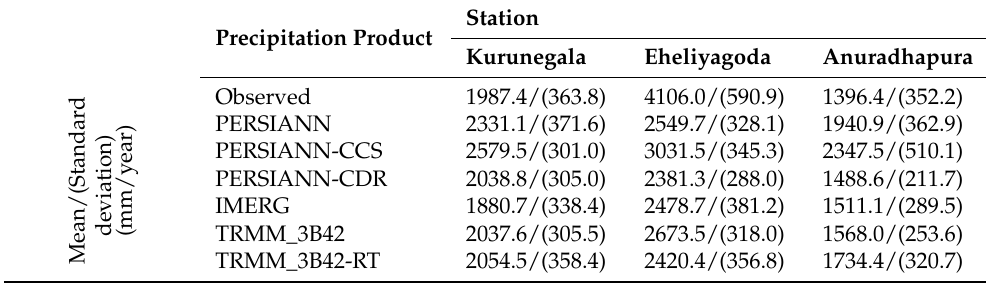
Table 3. Statistical information for selected stations.